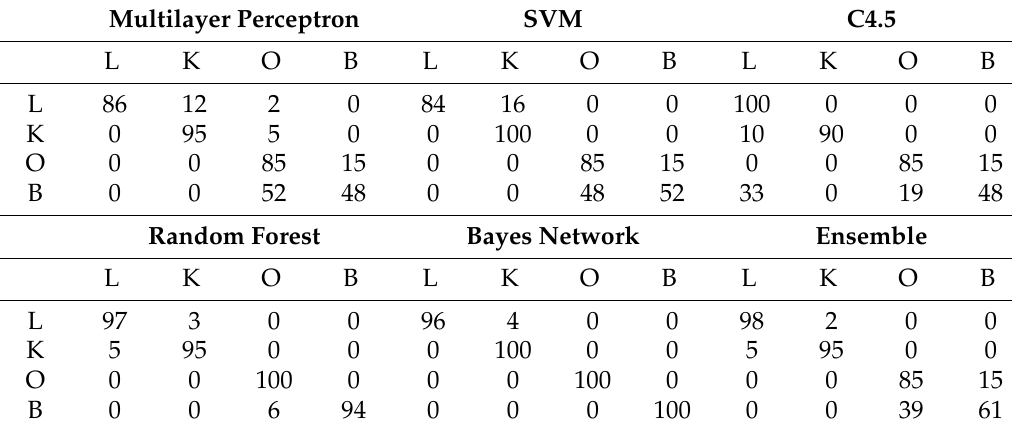
Table 7. Confusion matrix for the first scenario. The samples for training were taken with the user moving, and standing up for testing. The meaning of the capital letters are: L: Living-room, K: Kitchen, O: Office, B: